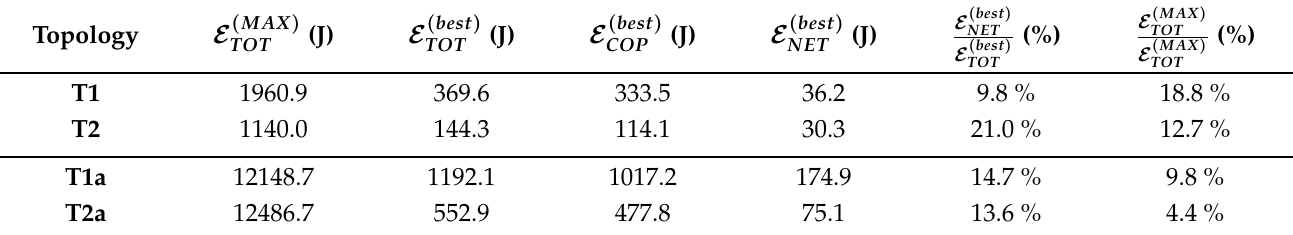
Table 6. Energy comparison under the test T 1 and T 2 Fog topologies.